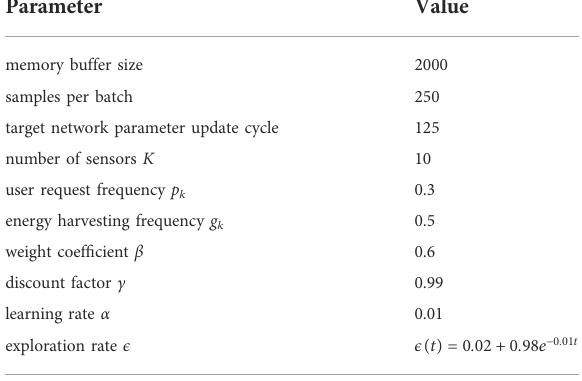
FIGURE 8 Proportion of sensor energy cost and proportion of information sent to users with an accuracy of more than 95%.